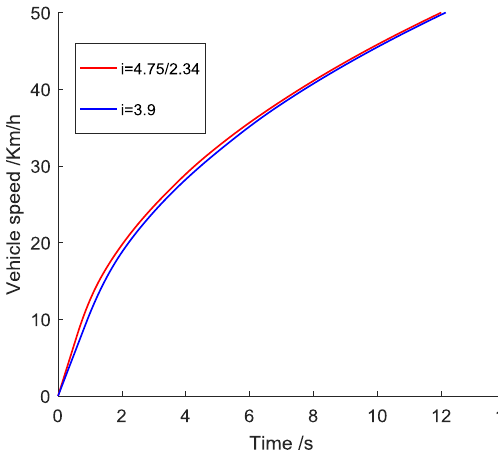
Figure 15. Acceleration time comparison.